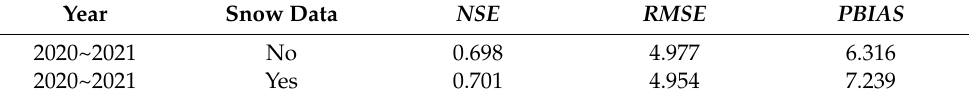
Table 2. Evaluation parameters for the random forest model of the Xiying River Basin from March